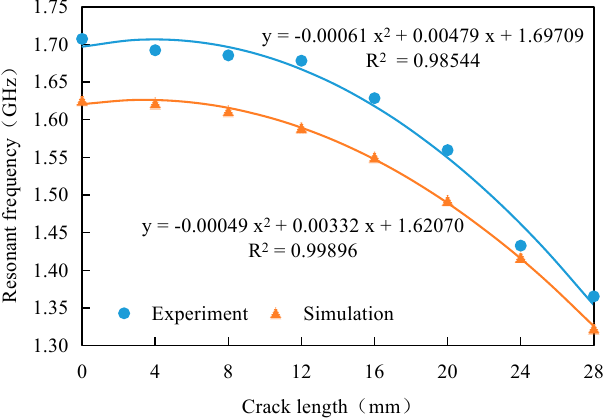
Figure 5. Relationship between resonant frequency and crack length.